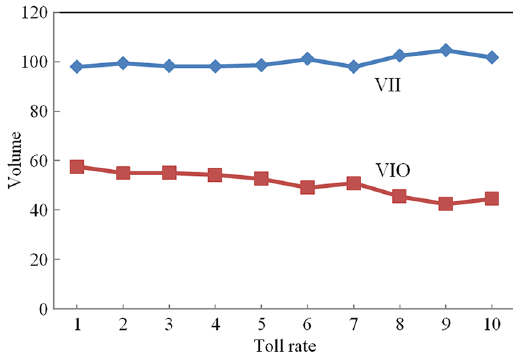
Fig. 9. Demand under different elastic parameters: